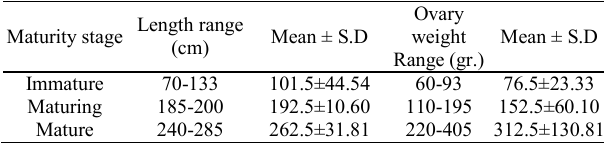
Table 1. Relationships between the maturity stages of female silky sharks, with total length of the specimens and ovary weight. Length range Maturity stage (cm)